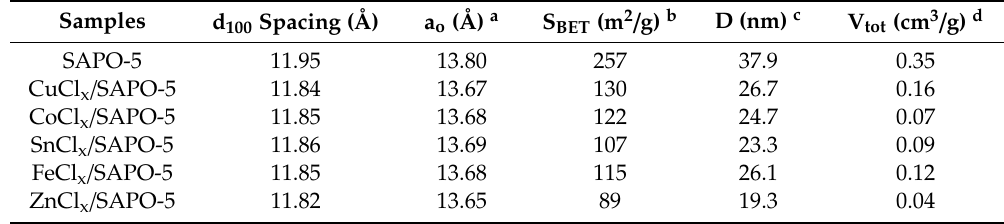
Table 3. Textural and surface properties of MCl x / SAPO-5 solids.